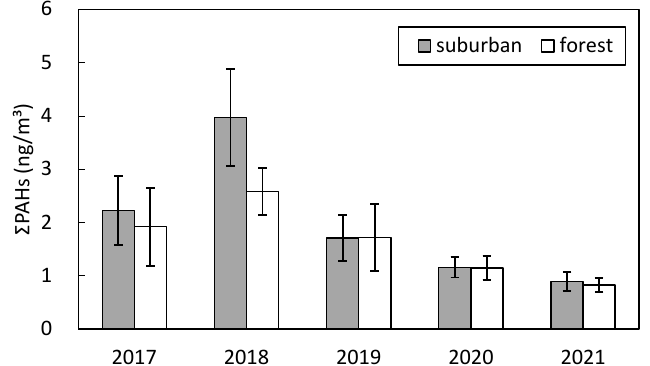
Figure 7. Behaviors in the annual average of total PAH concentrations in the suburban and forest sites of Nagasaki from 2017 to 2021. The error bars indicate the magnitude of the standard error. To understand this downward behavior, Figure 8 shows the results aggregated by season. The winter value changed more markedly than the other seasons, with a decrease of 72% in suburban site and 84% in forest site. Since the items (2) to (5) which are the reasons for the high PAH concentration in winter listed above would not have changed during this period, it is assumed that the results were due to an alteration in relation to item (1). Within China, measures are being taken to convert the domestic coal used for heating and cooking to natural gas, and renewable energy is being used extensively. In addition, according to Cao et al., PAH emissions from 2016 to 2020 from domestic coal